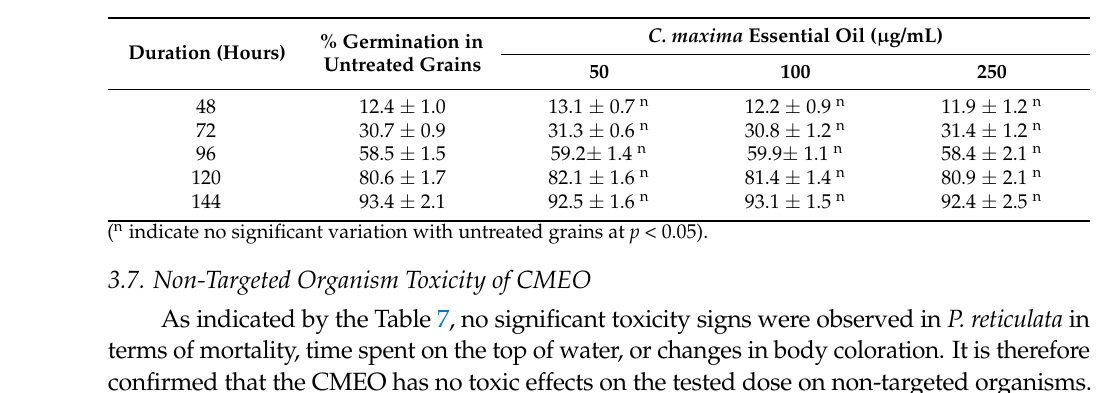
Table 7. Effect of CMEO on the non-targeted organism ( P. reticulata) and changes in the signs